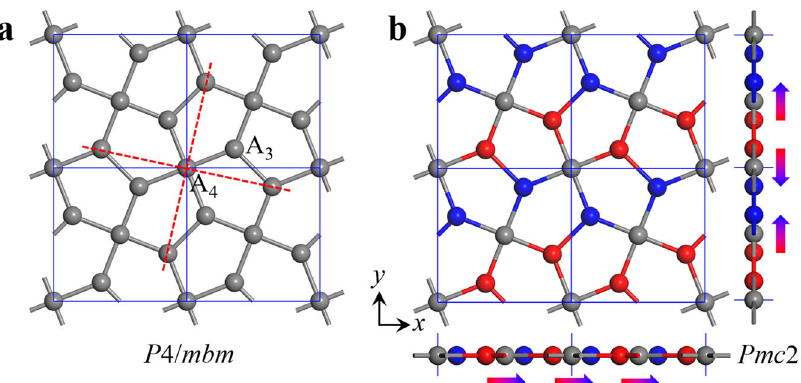
Fig. 1 Basic pattern for inducing in-plane polarization in pentagonal sheet. a Monatomic planar pentagonal structure with space group of P 4/ mbm . The red dashed lines show the inversion symmetry about A 4 atoms. b Proposed pentagon-based 2D structural model with in-plane polarization. The A 3 sites are occupied with two different elements, and marked in red and blue,